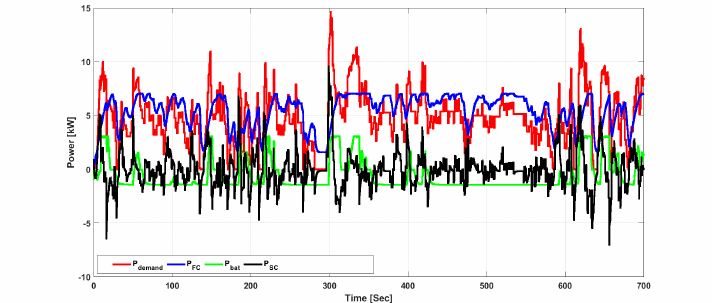
Figure 13. Power demand ( P demand ), FC power ( P FC ), battery power ( P bat ), and supercapacitor power ( P SC ) for the EMS based on the